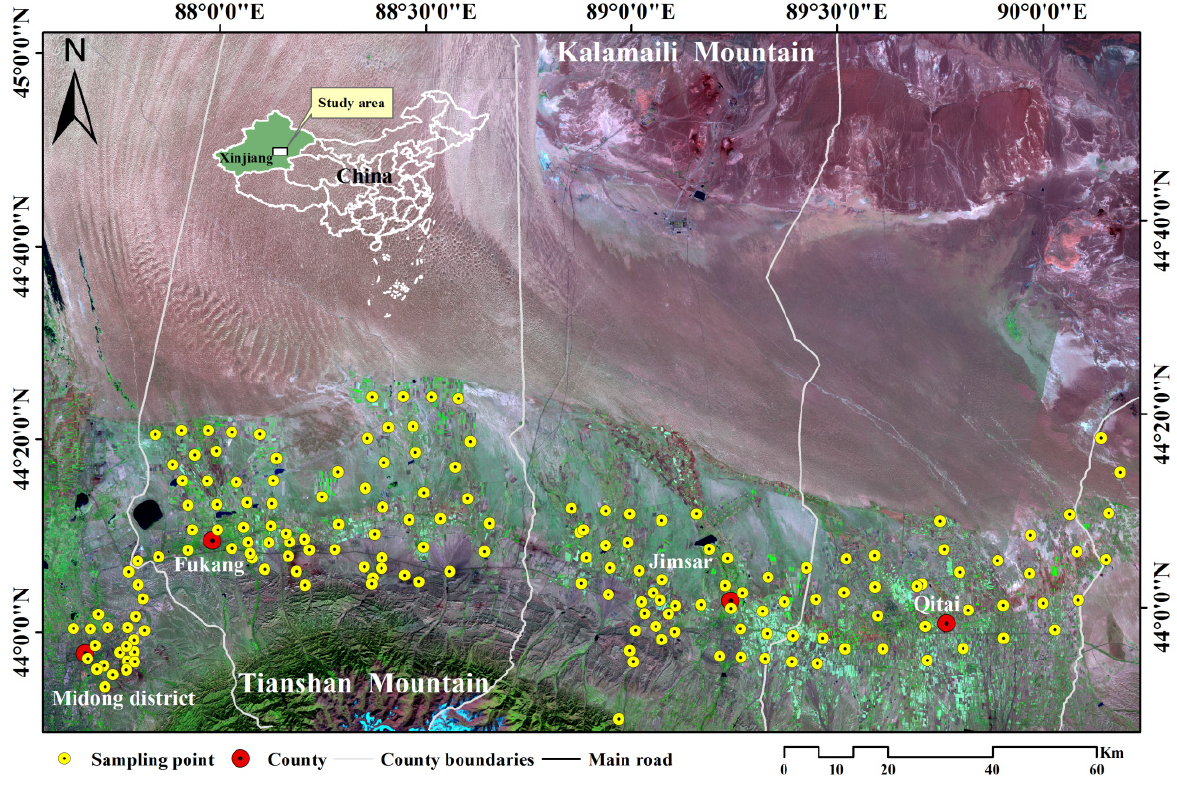
Figure 1. Sketch map of the study area.